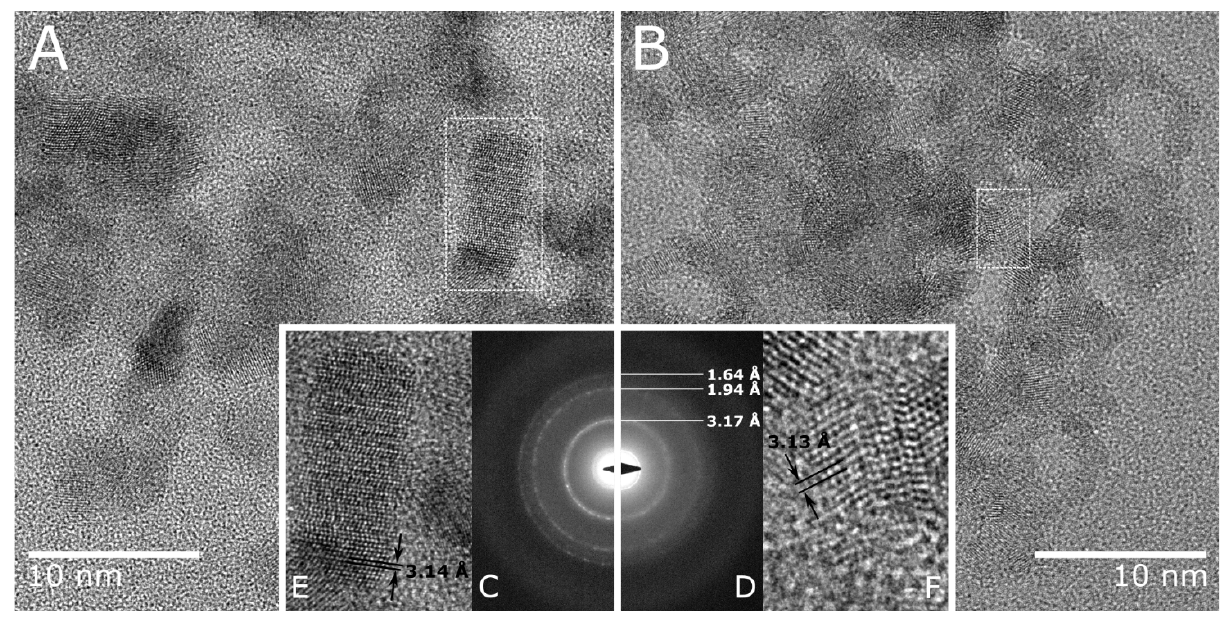
Figure 5. HRTEM images ( A , B ), selected area diffraction (SAED) ring patterns ( C , D ), and lattice fringes corresponds to the (111) lattice plane ( E , F ) of Cat-4H ( A , C , E ) and Cat-4E ( B , D , F ).